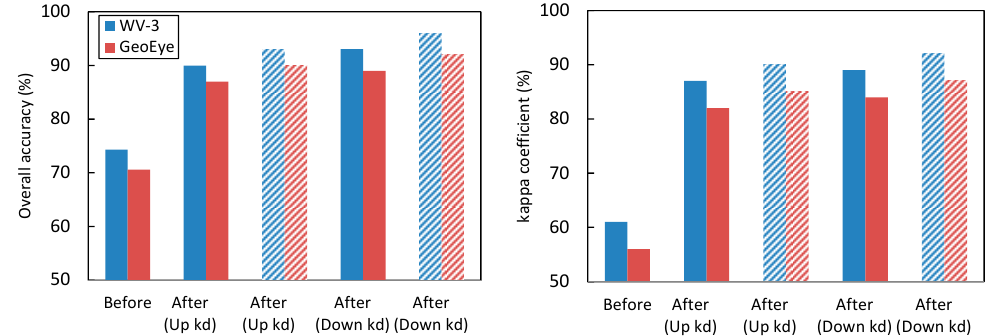
Figure 11. The overall accuracies and kappa coefficients of the bottom maps before and after water-column correction. The statistics are presented for upstream (Up) and downstream (Down) 𝐾 (cid:3031) retrievals for WV3 and GeoEye spectra. The accuracies with applying deep-water correction are shown by hatched bars.